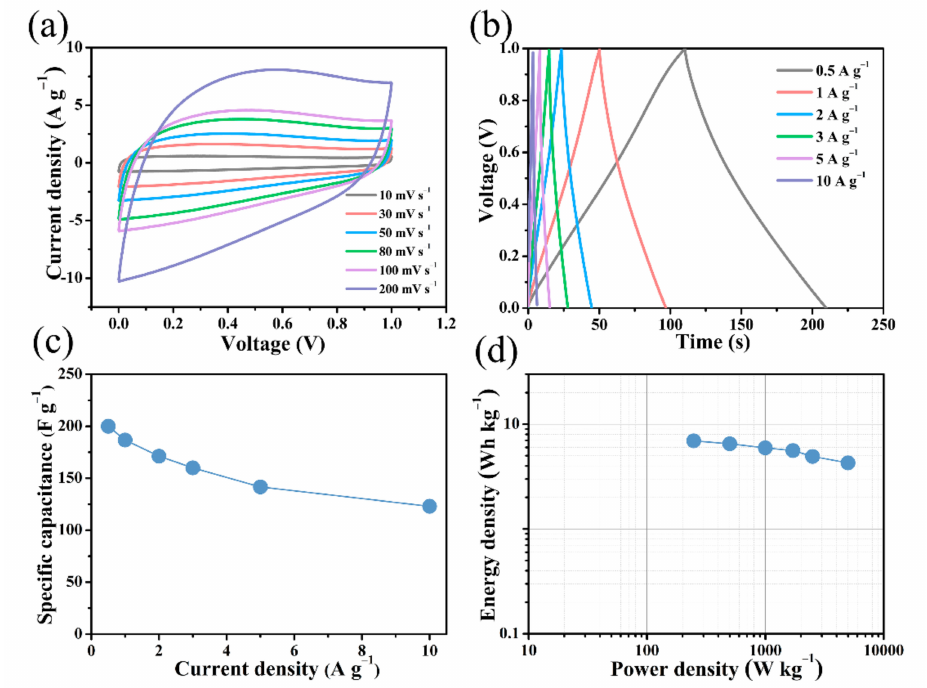
Figure 8. Electrochemical performance of B/S-SC S -1//B/S-SC S -1 symmetric supercapacitor using 6 M KOH electrolyte. ( a ) CV curves at various scanning rates; ( b ) GCD curves under various ampere densities between 0.5 and 10 A g − 1 ; ( c ) gravimetric capacitance as a function of specific current; ( d ) Ragone